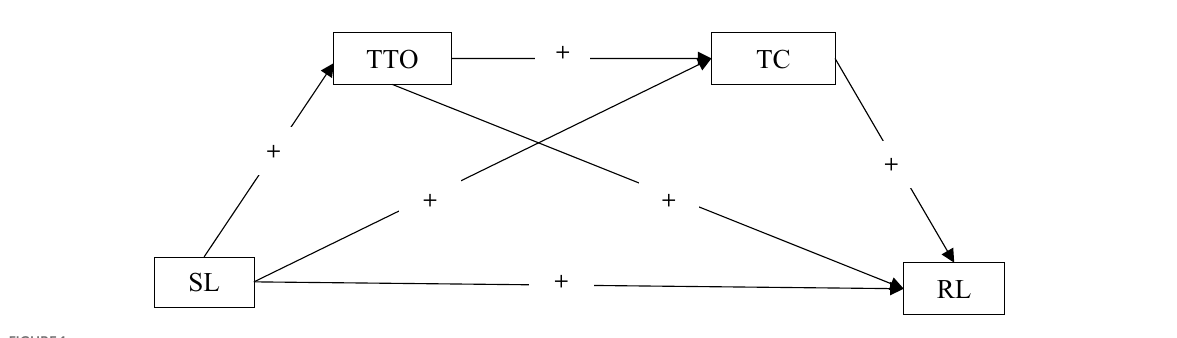
FIGURE 1 Proposed serial mediation model linking school leadership to student reading literacy in rural China. SL, School leadership; TTO, Teacher trust in others; TC, Teacher commitment; RL, Reading